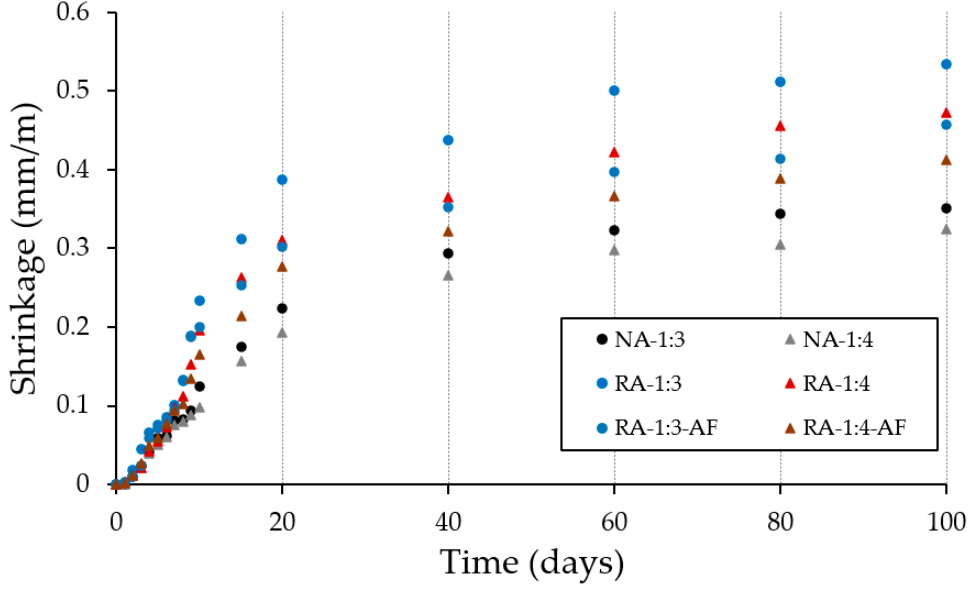
Figure 7. Shrinkage evolution (mm/m) during setting evolution (days).